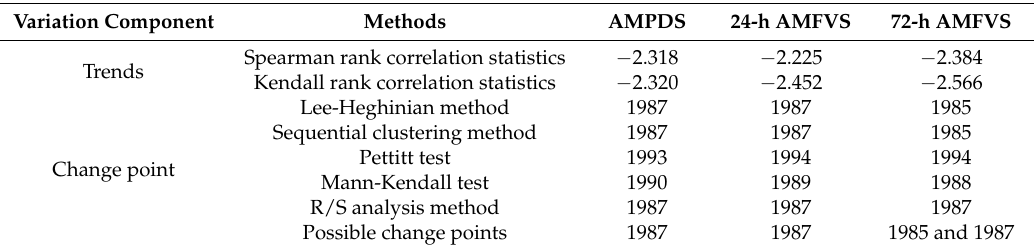
Table 4. Detailed diagnosis results.